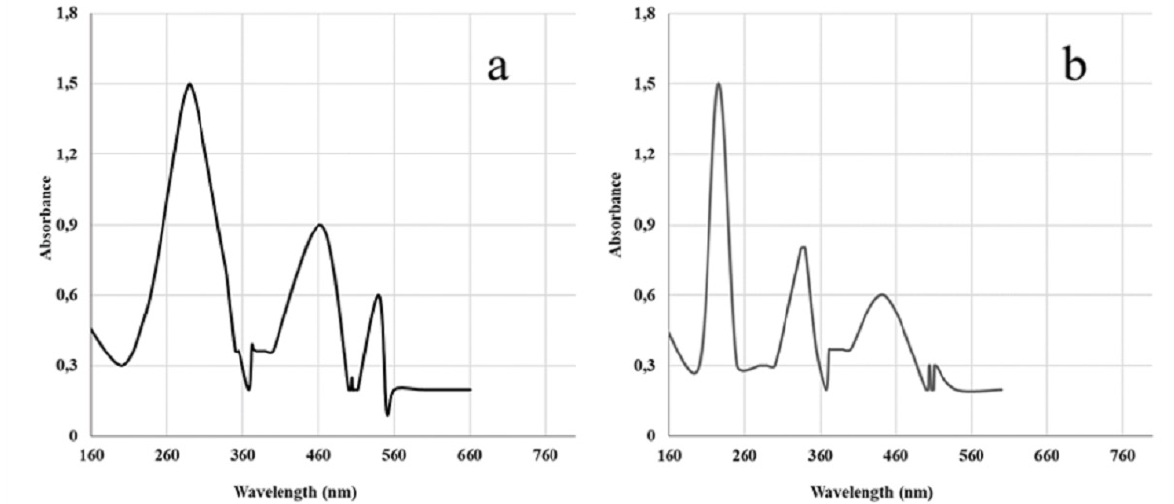
Figure 6. UV/Vis spectra for humates extracted from the faeces of Tapirus terrestres. (a) Humic acids, absorption bands at 290, 464, and 540 nm. (b) Fulvic acids, absorption peaks at 225, 335, and 445